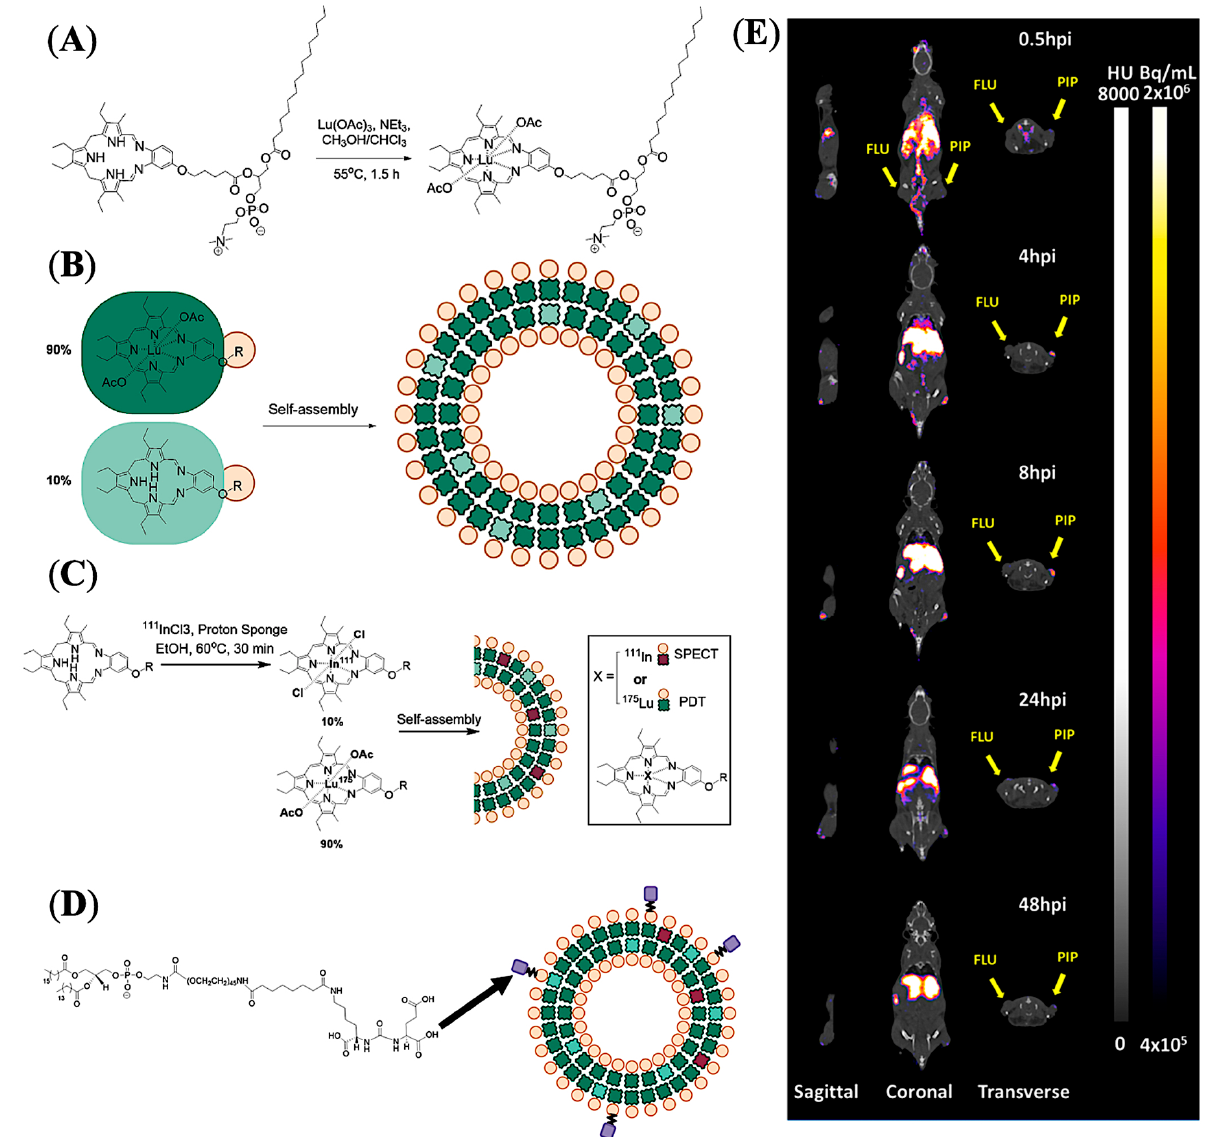
Figure 8. Imaging and treatment of prostate cancer in mouse models using PSMA-targeted liposome-like texaphyrin NPs. ( A ) Synthetic scheme showing chelation of lutetium with texaphyrin − lipid. ( B ) Formulation and representation of nanotexaphyrin self-assembly. ( C ) Radiolabeling conditions and schematic representation of 111 In/Lu-labelled nanotexaphyrin. ( D ) Schematic representation of PSMA-targeting ligand (ACUPA) conjugated 111 In/Lu–nanotexaphyrin. ( E ) mSPECT/CT images of a mouse model bearing dual xenografts of PC3-Pip and PC3-Flu. Reprinted with permission from Ref [61]. Copyright 2022, American Chemical